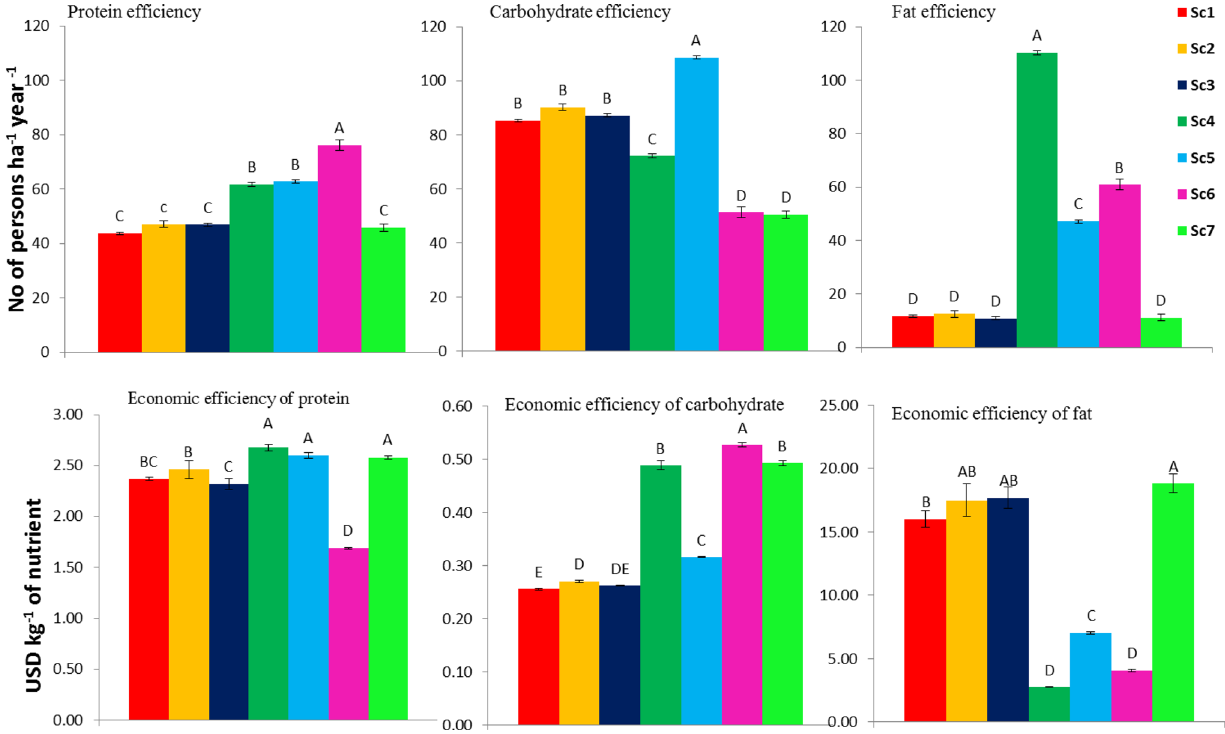
Figure 3. Yearly protein, carbohydrate and fat demand (based on 58, 275 and 30 g day −1 adult −1 ) equivalents for adults and economic efficiency of protein, carbohydrate and fat as affected by different cropping systems under various management scenarios (2 year`s